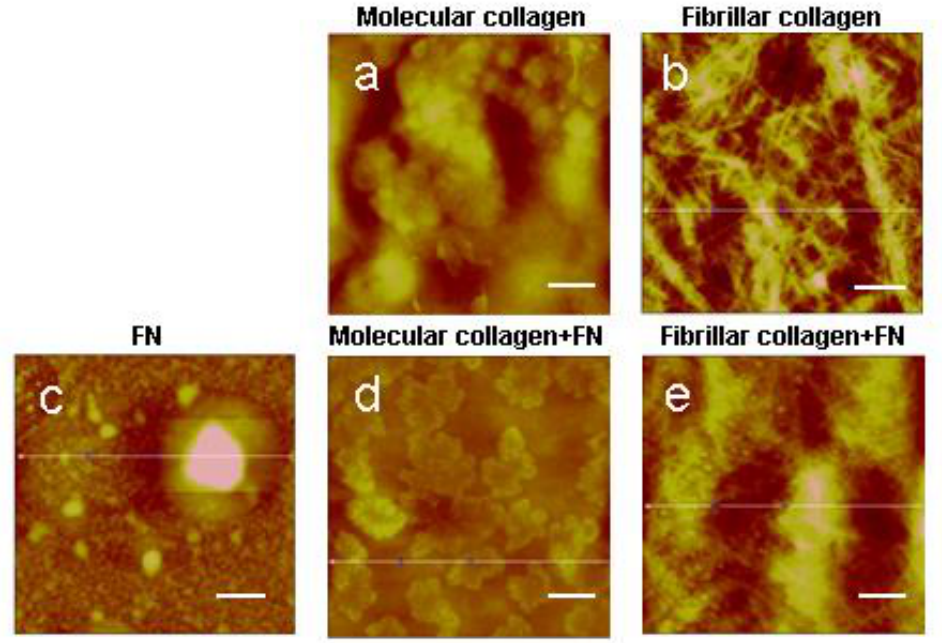
Figure 1. AFM images of molecular and fibrillar collagen with/without fibronectin (FN): ( a )—molecular collagen; ( b )—fibrillar collagen; ( c )—fibronectin; ( d )—molecular collagen + fibronectin; ( e) — fibrillar collagen + fibronectin. Scale bar 1 µm.